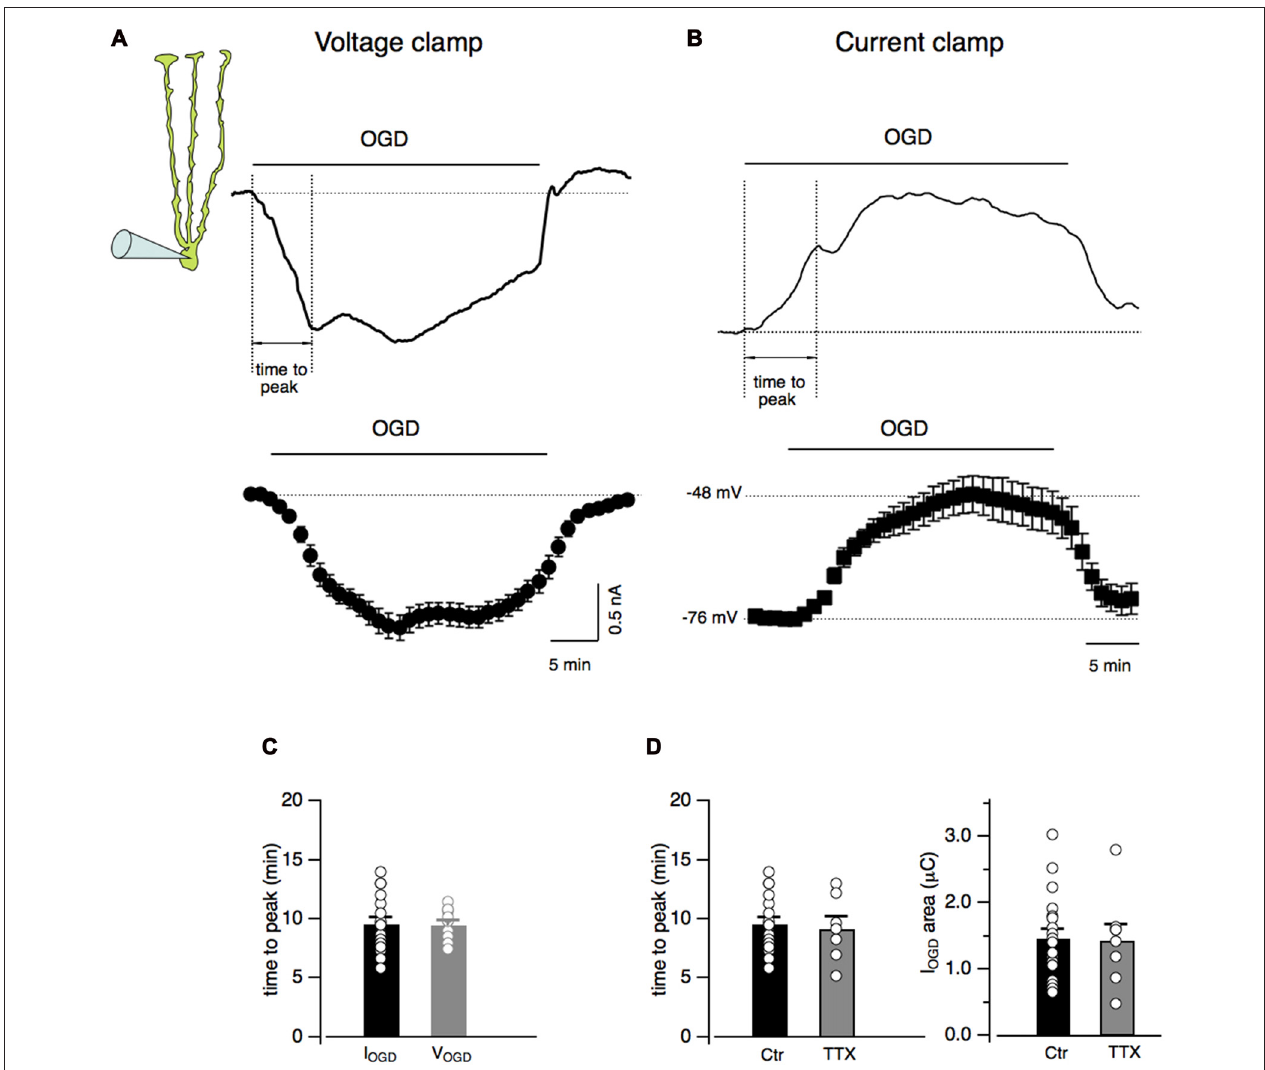
FIGURE 1 | Oxygen and glucose deprivation (OGD) induces inward currents and membrane depolarization in Bergmann glial cells. (A) Current response of a Bergmann cell to 30 min of OGD (I OGD ). The membrane potential is held at − 70 mV. At the bottom, current traces from several Bergmann cells ( n = 19) are averaged every minute. (B) Representative current clamp recording (V OGD ) from a Bergmann cell during OGD. No current was injected in these experiments. Note that Bergmann glia depolarizes gradually during OGD while, in the post-OGD phase, the recovery toward the baseline membrane potential is faster. The time-dependent changes in membrane potential from n = 12 Bergmann cells during OGD is shown at the bottom. (C) Time intervals between the beginning of the OGD and the first peak of the response (dashed lines, “time to peak” in (A,B) are indicated for both I OGD ( n = 23) and V OGD ( n = 12; P = 0.88)). (D) The time to peak (Ctr, n = 23 and TTX, n = 7; P = 0.86, right) and the electrical charge underlying I OGD (Ctr, n = 19 and TTX, n = 8; P = 0.93, left) are reported in control and in the presence of TTX (1 µ M) for each recorded cells: there is no statistical difference between the two cell populations.